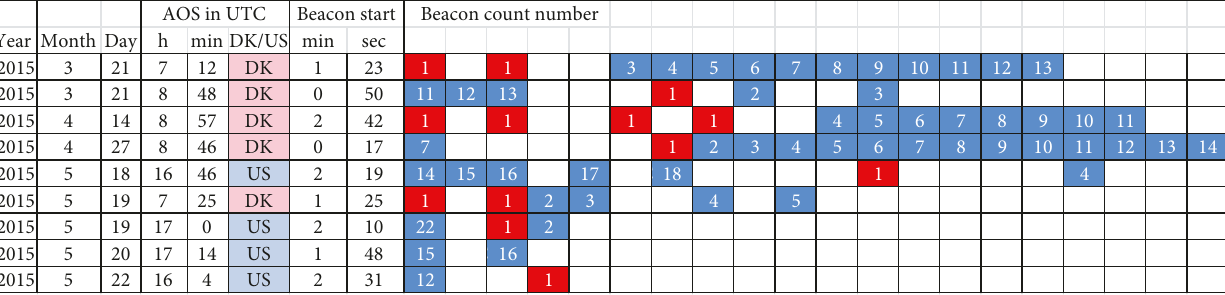
Figure 9: The table shows a small selection of the decoded beacon data to be visualized. “ Beacon start ” indicates how long into the recording the fi rst beacon appears. Each column indicates a 30 second interval. The full data set is listed in Appendix. applicable for limited time spans only. The concept is